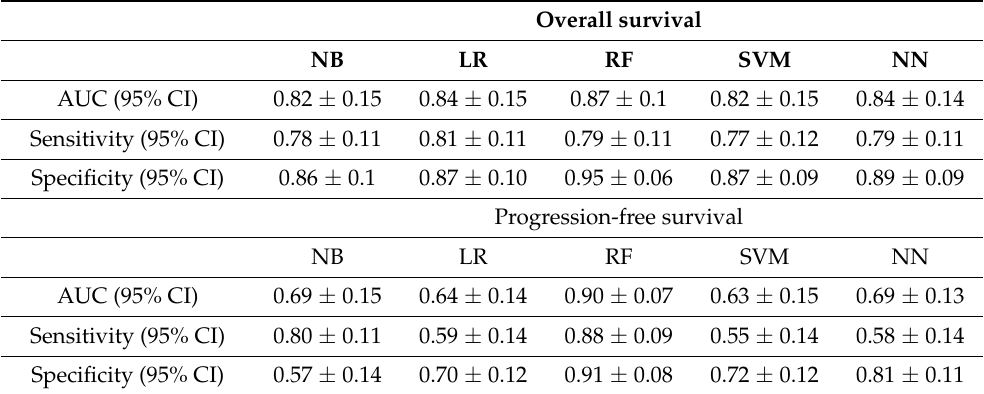
Table 2. Performance of each model using cross-validation to predict overall survival and progression- free survival at one year, in patients with metastatic